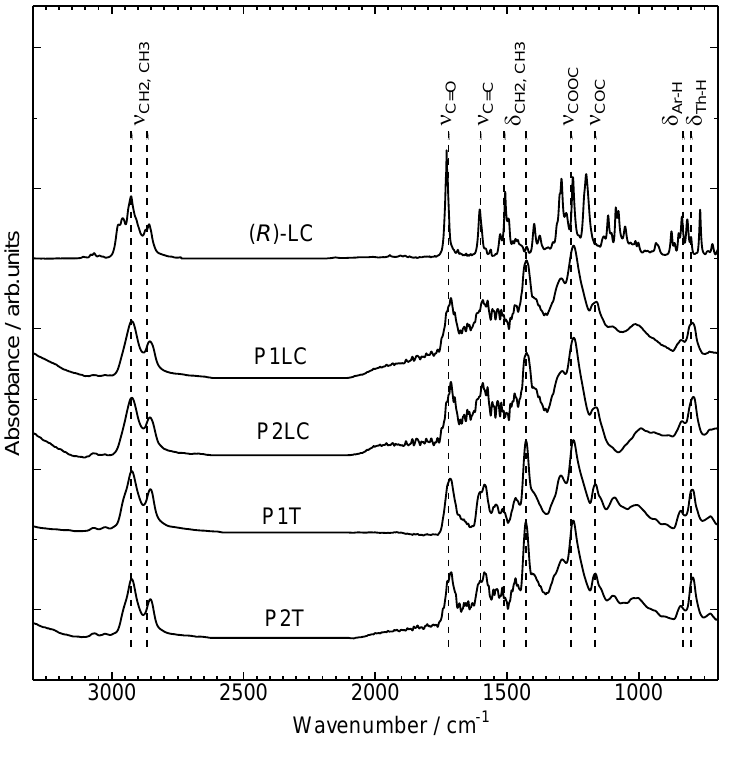
Figure 1. Infrared (IR) absorption spectra for the ( R )-LC, P1LC, P2LC, P1T, and P2T with the KBr